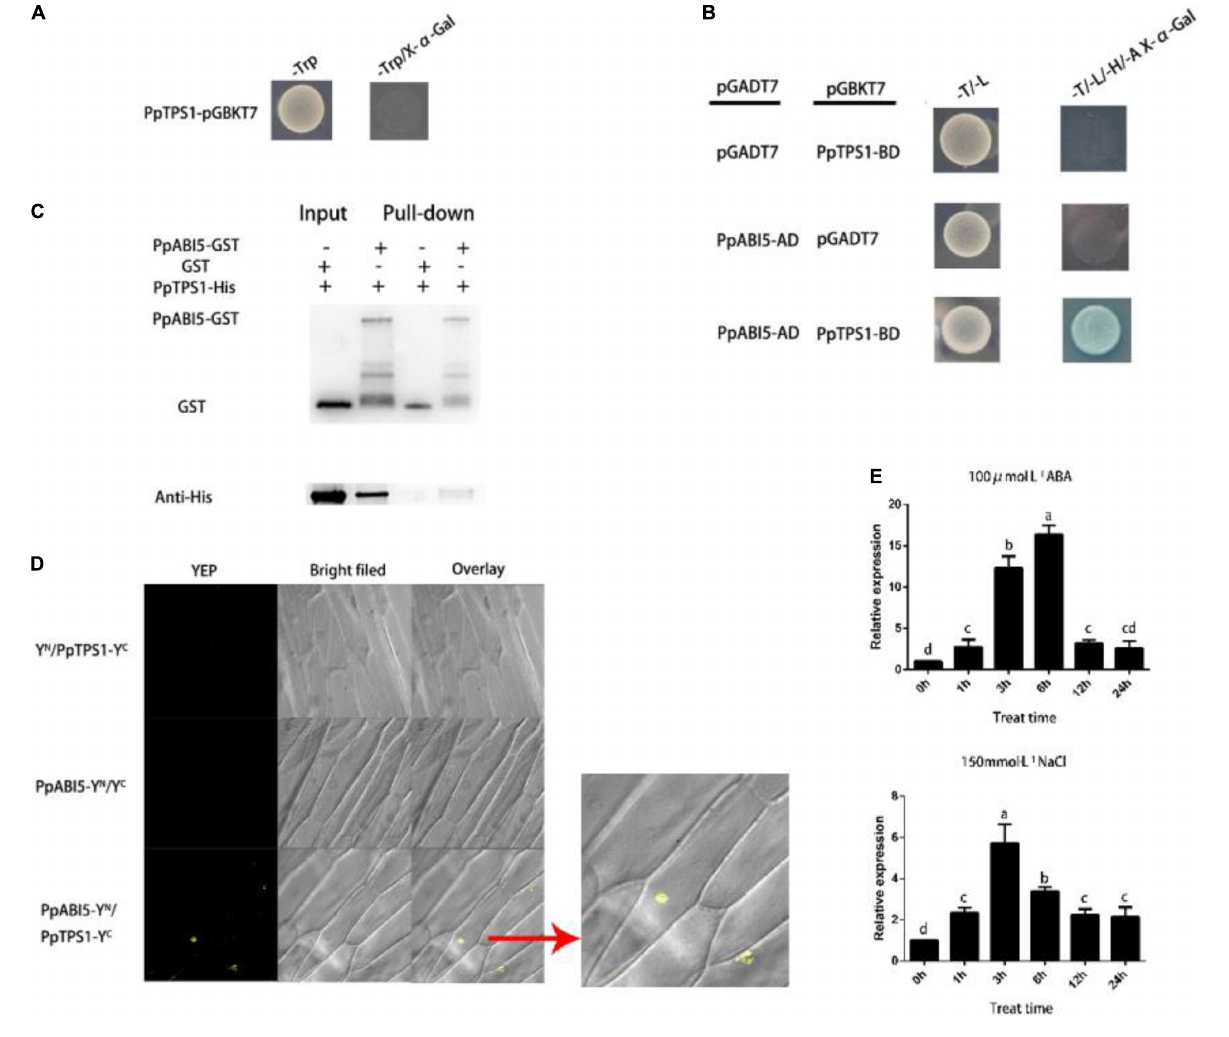
FIGURE 3 | PpABI5 interacts with PpTPS1 and responds to salt stress. (A) PpTPS1 has no autonomous activation activity. (B) Verification of the interaction between PpTPS1 and PpABI5 by a yeast two-hybrid (Y2H) experiment. Yeast containing PpTPS1-BD and PpABI5-AD can grow on DDO (SD/-Leu/-Trp), and they can also grow and turn blue on QDO (SD-Leu/-Trp/-His/-Ade/X- α -Gal). (C) GST pull-down analysis verified the interaction of PpTPS1 and PpABI5 . GST, PpTPS1-His, and PpABI5-GST proteins were all purified once before the experiment. (D) Bimolecular fluorescence complementation (BiFC) verification of the interaction between PpTPS1 and PpABI5 . (E) Annual peach leaves treated with 100 µ M ABA and 150 mM NaCl for 0, 1, 3, 6, 12, and 24 h were used as samples to analyze the expression of the PpABI5 model. Biological triplicates were performed for each sample. Different letters represent significant differences according to ANOVA and Duncan’s test ( P <